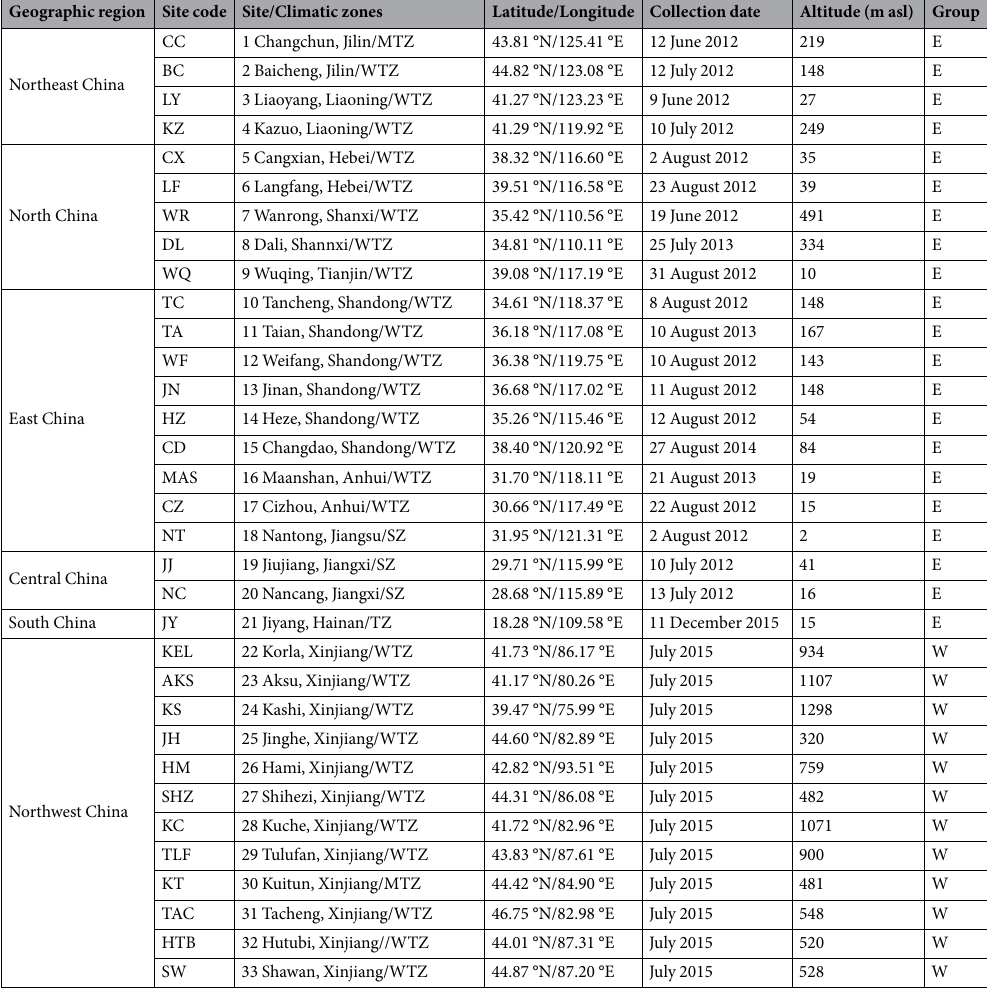
Table 2. Habitat location, sample size and regional group information of Aphis gossypii in different geographic populations. Sites are labeled according to abbreviated location names for Aphis gossypii . MTZ, mid- temperature zone; WTZ, warm temperate zone; TZ, tropical zone; and SZ, subtropical zone; E, eastern region group; W, western region